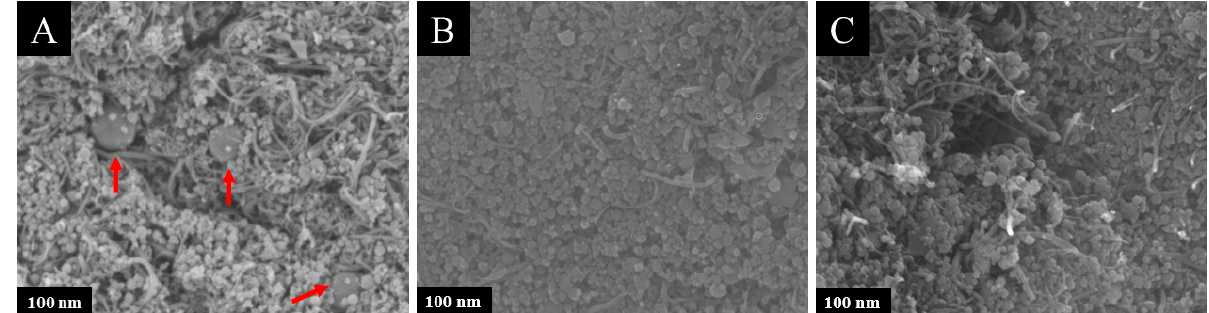
Figure 6. SEM images of ( A ) composite 1, ( B ) composite 2 and ( C ) composite 3 impregnated into Ni foam current collectors. Arrows show large particles in composite 1. Composite 1 was prepared